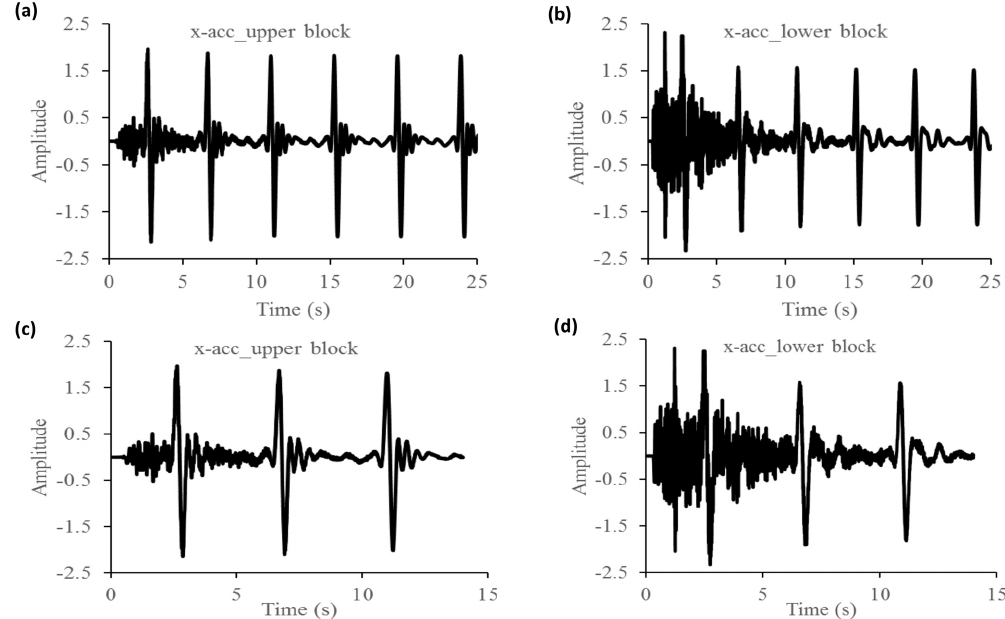
Figure 10. x acceleration for 25s (a, b) and 14s (c, d) computational time. Accelerations labelled as “x-acc_lower block” and “x-acc_upper block” correspond, respectively, to history points 15 and 12 mentioned in Fig.